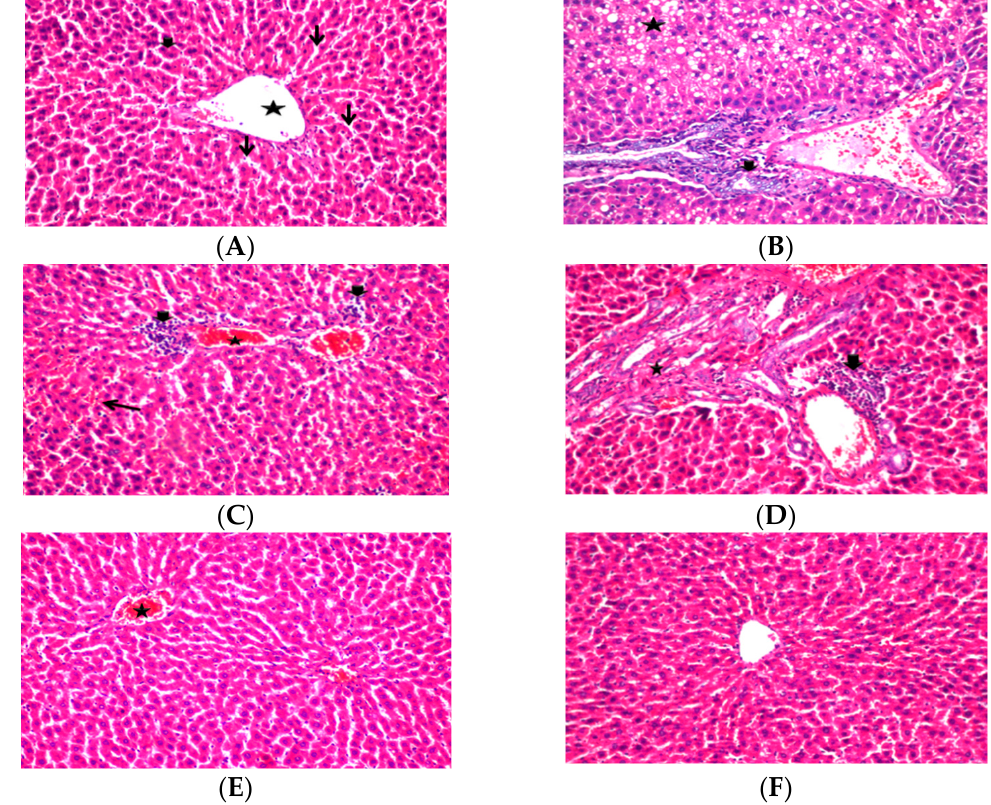
Figure 3. Histopathological examination of liver tissue (H&E x200) showing damage and arrangement of hepatocytes and fat vacuoles; ( A ) tissue from the NC group showing a normal liver with no lipid deposits; ( B ) liver tissue from the PC group showing the presence of steatosis; ( C ) tissue from the Co-T group showing congested blood vessels and sinusoids, Kupffer cells hyperplasia, and lymphocytic infiltrations; ( D ) tissue from the Ca-T group showing peri-artery inflammatory cells aggregations mainly lymphocytes; ( E ) cells from the Ca_Co-T group showing nearly normal hepatic lobules with mild congested central vein; and ( F ) tissue from the Ca_Co-P group showing apparently normal hepatic lobe.